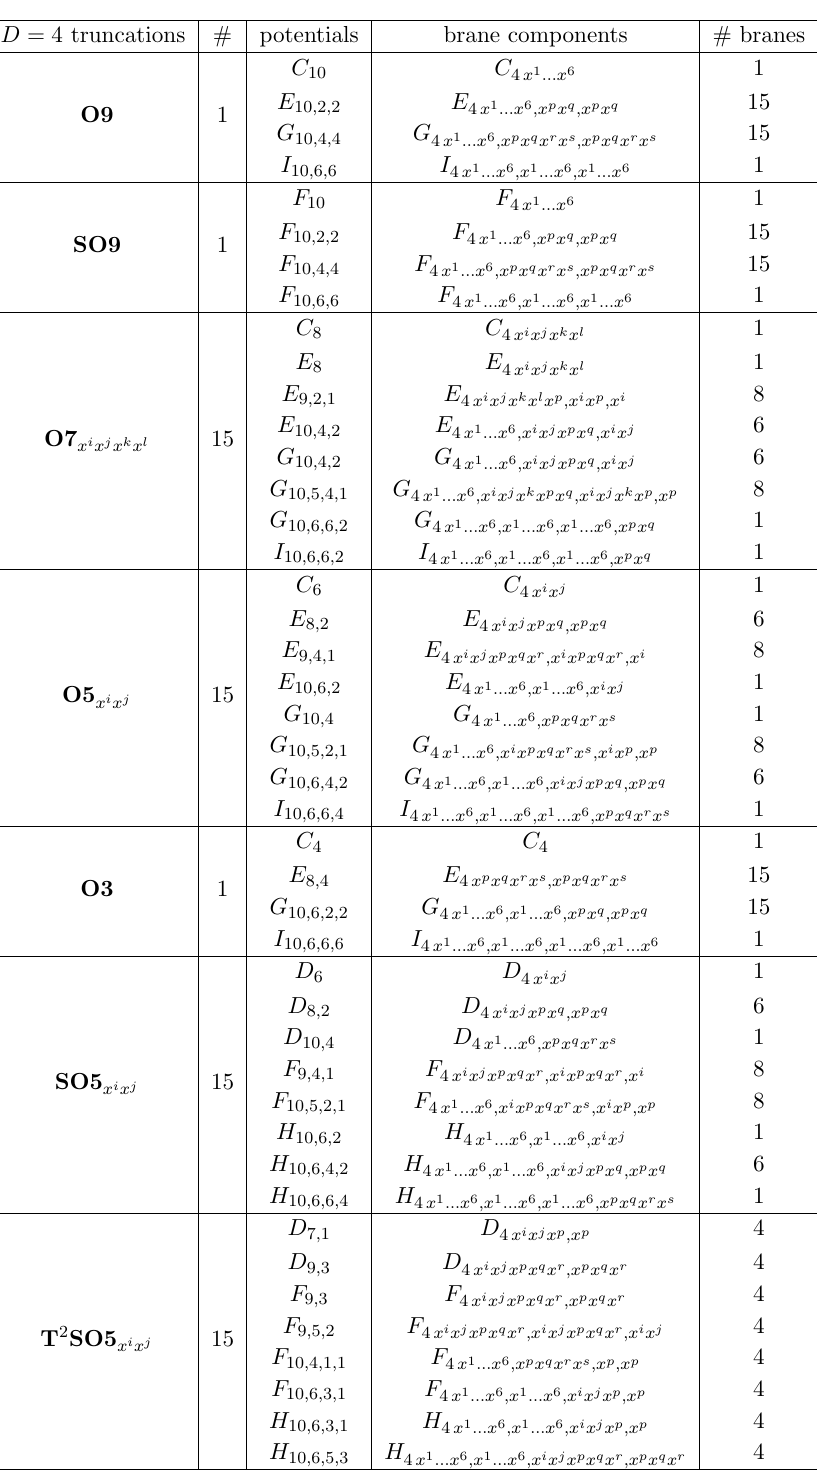
Table 9 . The Z 2 truncations of the maximal theory in D =